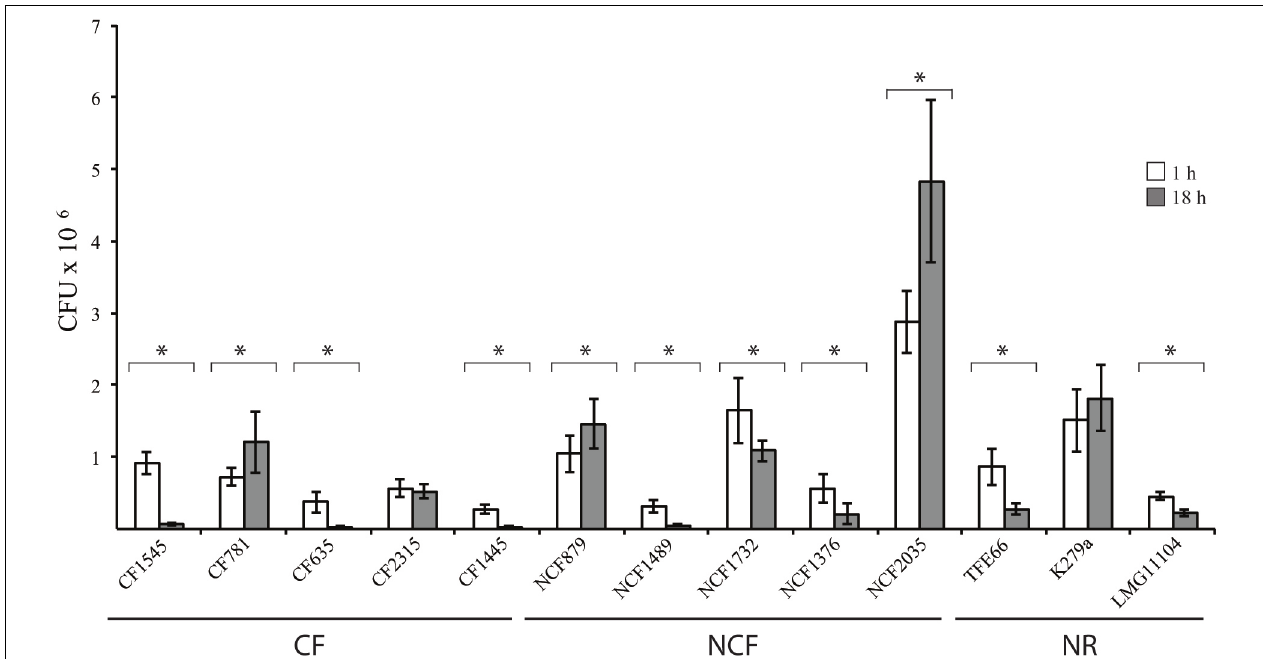
FIGURE 1 | Interactions of S. maltophilia strains with iDCs. White and gray bar graphs indicate CFUs recovered by iDCs after 1 h and 18 h of infection, respectively. * p < 0.05. Each bar indicates the mean value (cid:6) standard deviation of at least three independent experiments in